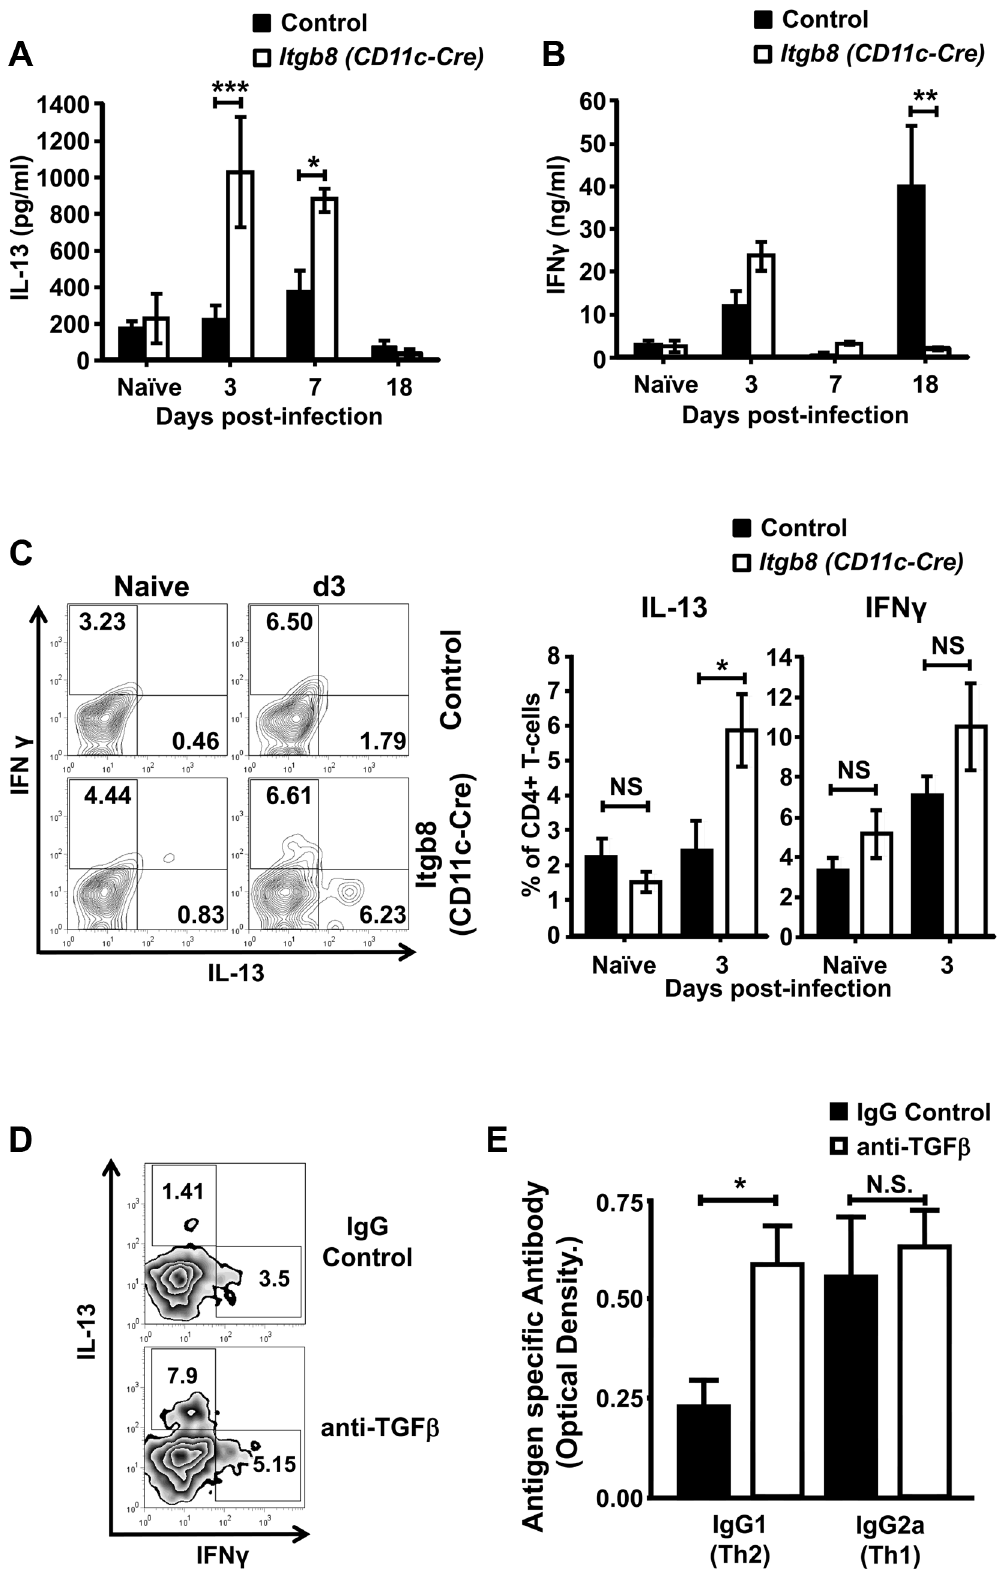
Figure 4. Mice lacking the TGF b -activating integrin a v b 8 on DCs demonstrate an enhanced IL-13 production in LILP CD4 + T-cells. ( A ) IL-13 and ( B ) IFN c cytokine levels from T. muris E/S antigen-stimulated mLN cells from control and Itgb8 (CD11c-Cre) mice at different time-points post-infection ( p.i.) with a chronic dose of T. muris eggs, determined via cytometric bead array/ELISA. Data (n=5–6 mice per group) are from three or